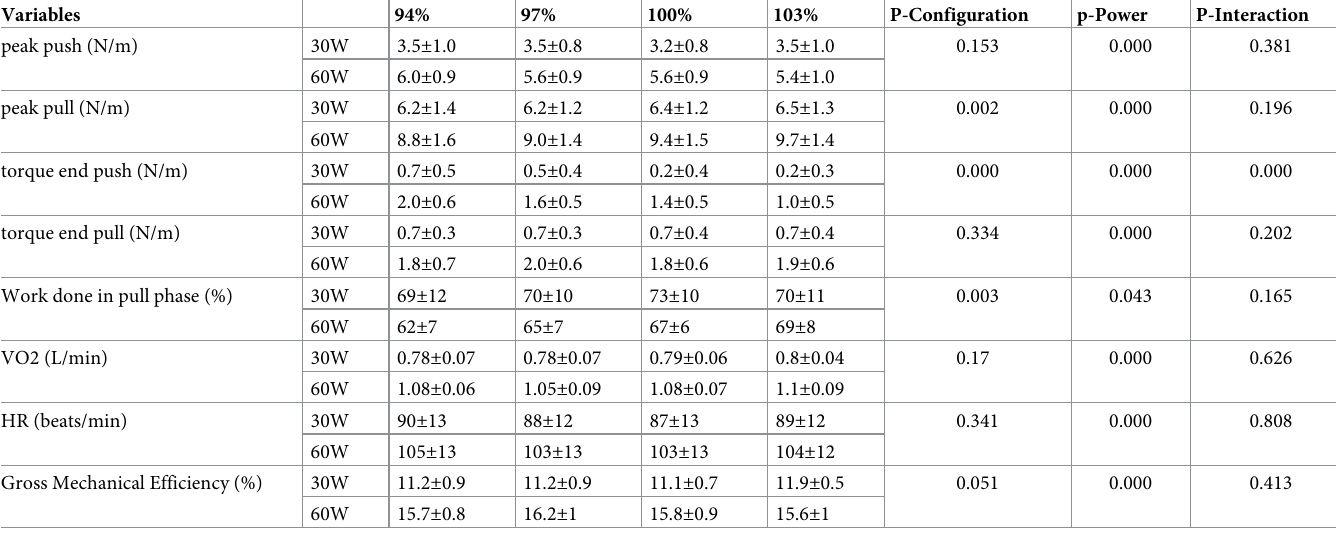
Table 2. Means and standard deviations of all analysed dependent variables and results of the two-way repeated measures Anova. Variables